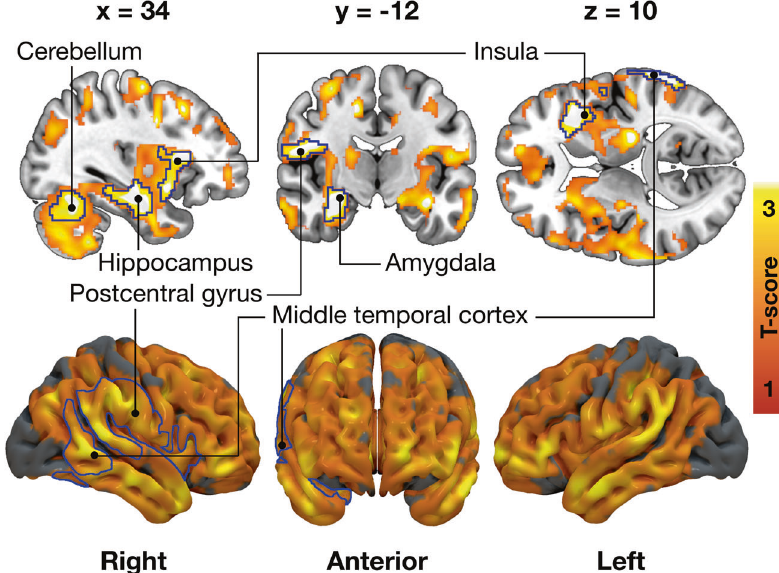
Fig. 3 Association between External eating and decreased μ -opioid receptor availability in the 92 subjects (70 males and 22 females) scanned with [ 11 C]carfentanil. The blue outline marks brain regions where lower [ 11 C]carfentanil binding potential ( BP ND ) associated with higher External eating score, age and PET scanner as nuisance covariates, cluster forming threshold p < 0.01, FWE corrected. In the red – yellow T-score scale shown are also additional bilateral associations signi fi cant with more lenient cluster-de fi ning threshold ( p < 0.05, FWE corrected) for visualization purposes.